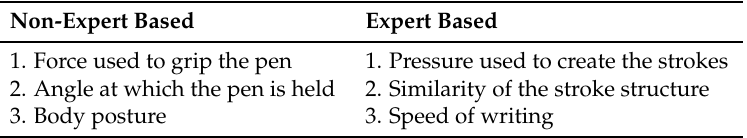
Table 1. Types of expert attributes identified.